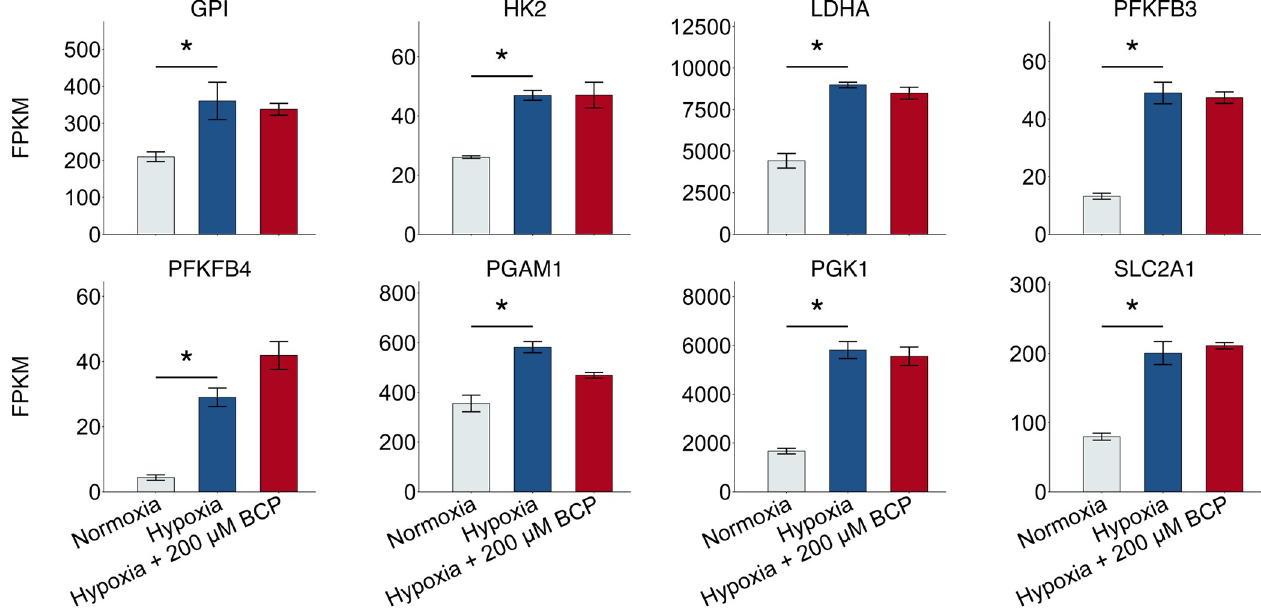
Fig 2. Hypoxia-sensitive glycolytic genes are not affected by BCP. RNAseq data (GSE125511), generated from cells exposed to hypoxic conditions in the presence or absence of BCP, were queried for hypoxic-sensitive glycolytic genes. Bars represent 3 independent experiments for each experimental condition with a q-value cutoff of � 0.05. Asterisks connecting Normoxia and Hypoxia treatments indicate significant (q-value � 0.05) effects of Hypoxia; asterisks connecting Hypoxia and BCP treatment indicate significant effects of BCP (none in this